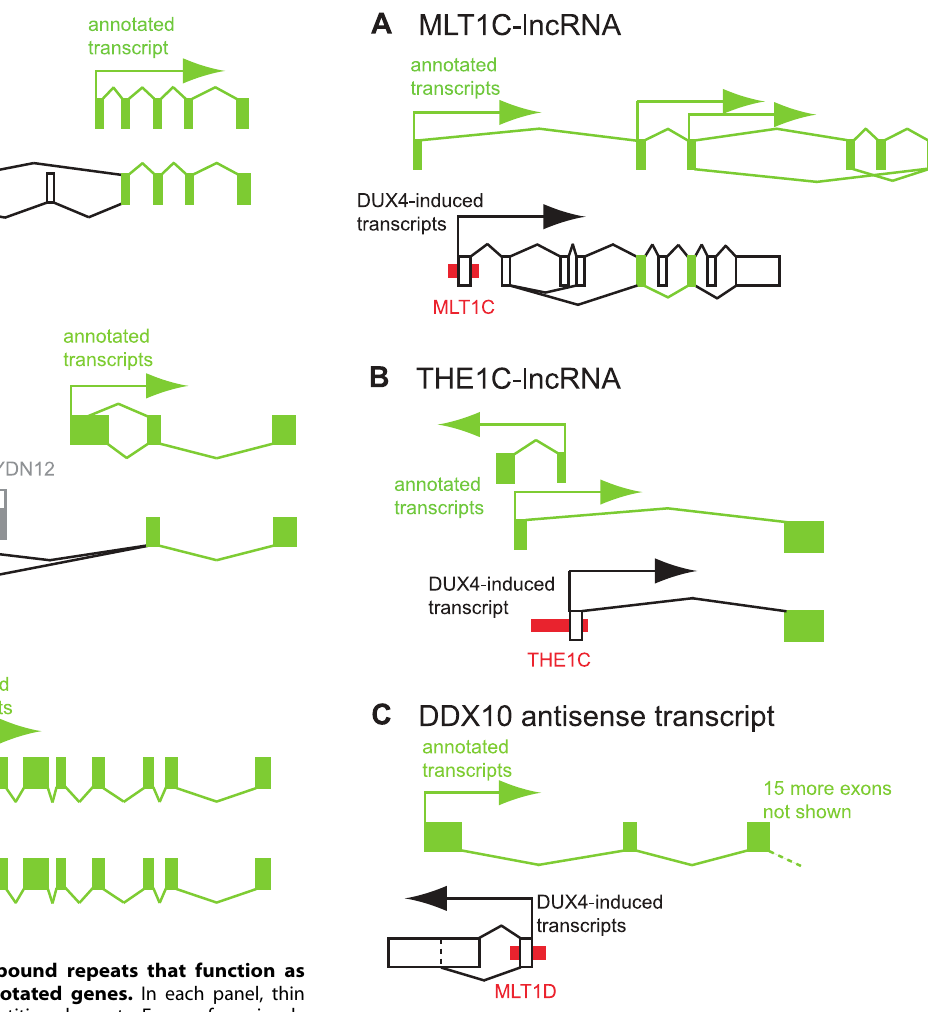
Figure 5. Examples of DUX4-bound repeats that function as alternative promoters for lncRNAs or antisense transcripts. In each panel, thin red boxes depict DUX4-bound repetitive elements. As in Figure 4, exons of previously annotated transcripts are depicted as green boxes, with alternative DUX4-induced exons as empty boxes (not to scale). Arrows show the direction of transcription. Diagonal lines show splicing, with alternative splice forms shown above and below the exons. (A) A lncRNA initiated at an MLT1C element. Two exons of the DUX4-activated lncRNA overlap with exons of previously described lncRNAs TCONS_00003193, TCONS_00002742, TCONS_00002660 and TCONS_00003194 [42]. (B) A lncRNA initiated at an THE1C element that shares the second exon of lncRNA TCONS_00022347 [42]. Additional lncRNAs on the opposite strand also initiate in this region - for clarity, only one is depicted here. (C) An antisense RNA initiated at a DUX4- bound MLT1D element that overlaps the first exon of DDX10 .